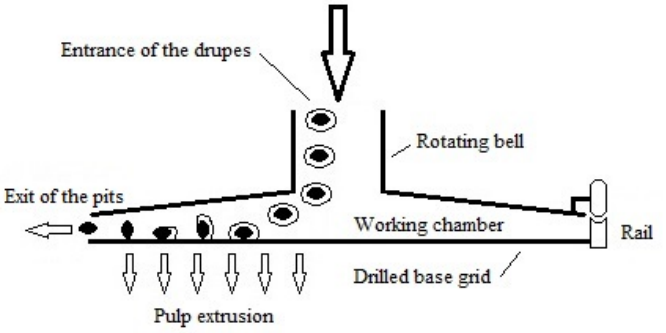
Figure 1. Conceptual scheme of the pitting prototype.